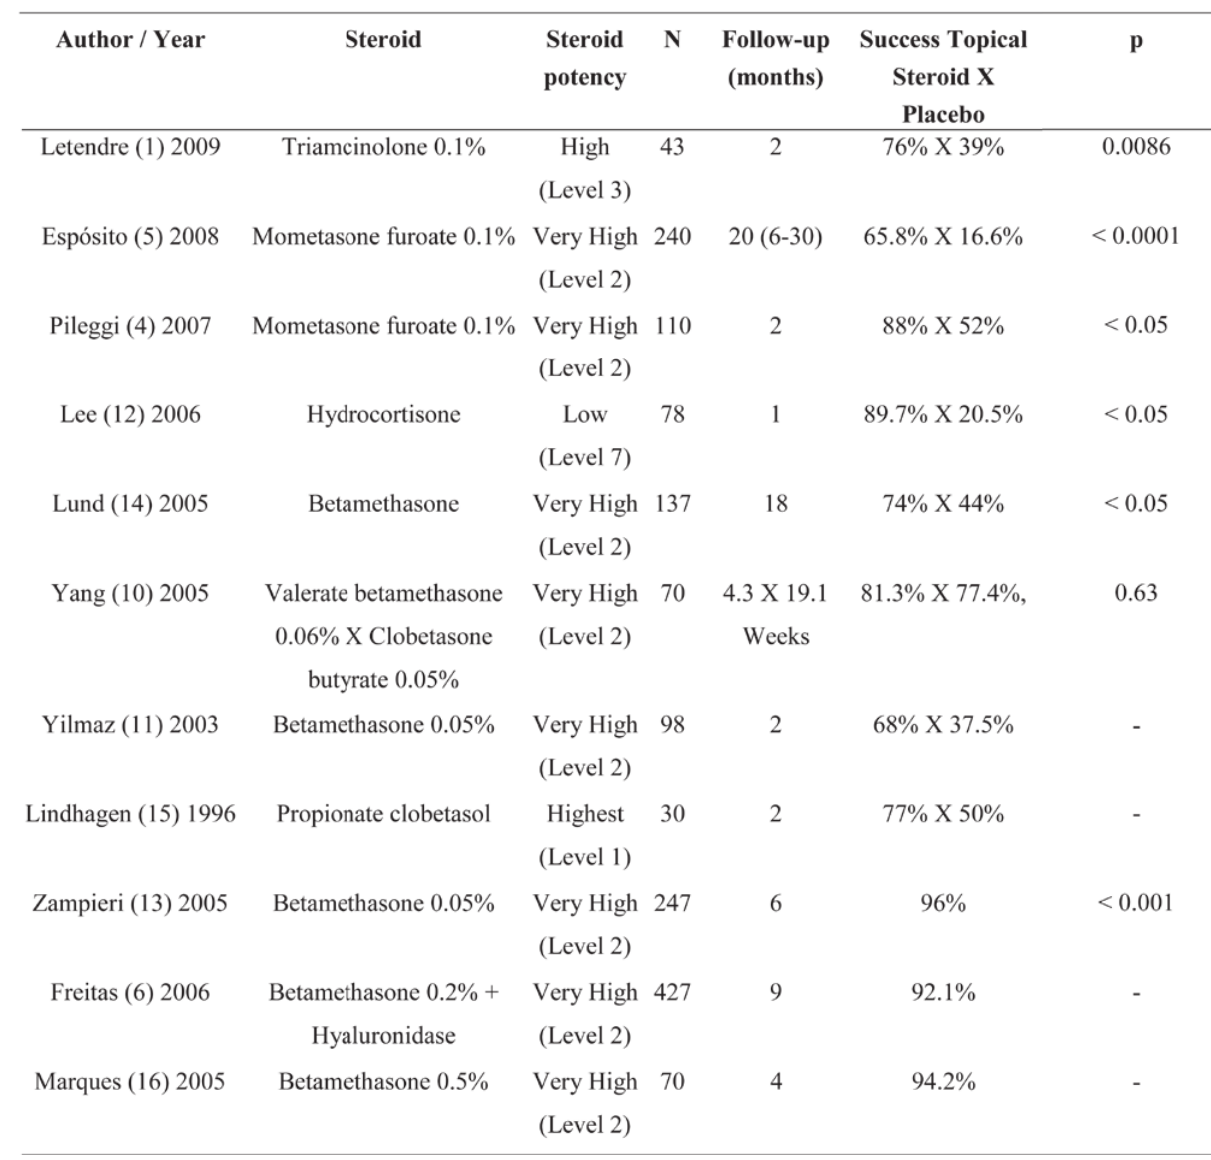
Table 1 - Placebo-Controlled, Randomized Trials with topical steroids in the treatment of phimosis